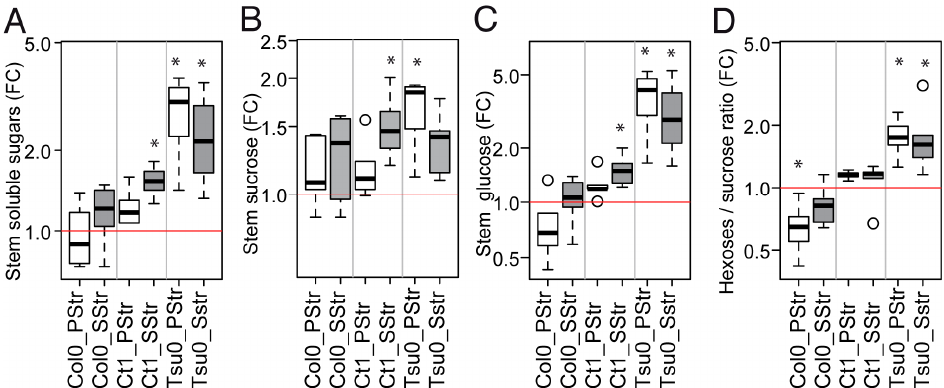
Figure 5. The natural variation of the response of the sugar content to salt treatment. Fold changes in the stem sugar contents in the PStr and SStr plants at 17 DAB. ( A – D ) The box and whisker plots represent the distribution of the biological replicates (see Figure 2 for details) with in ( A ) the fold changes in total soluble sugars, ( B ) the fold changes in sucrose, ( C ) the fold changes in glucose, and ( D ) the fold changes in hexoses-to-sucrose ratio ( n = 5–6). FC—fold changes. Stars denote the significant differences of the treatments compared to the control plants (* p < 0.05, n ≥ 5). White bars—PStr plants. Grey bars—SStr plants.